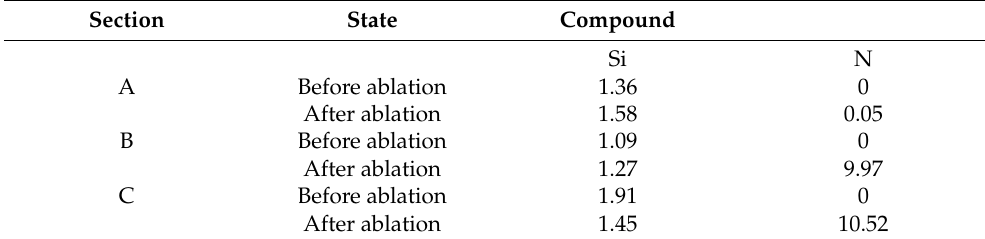
Table 6. Comparison of the elements in each section the the longitudinal sections (%).